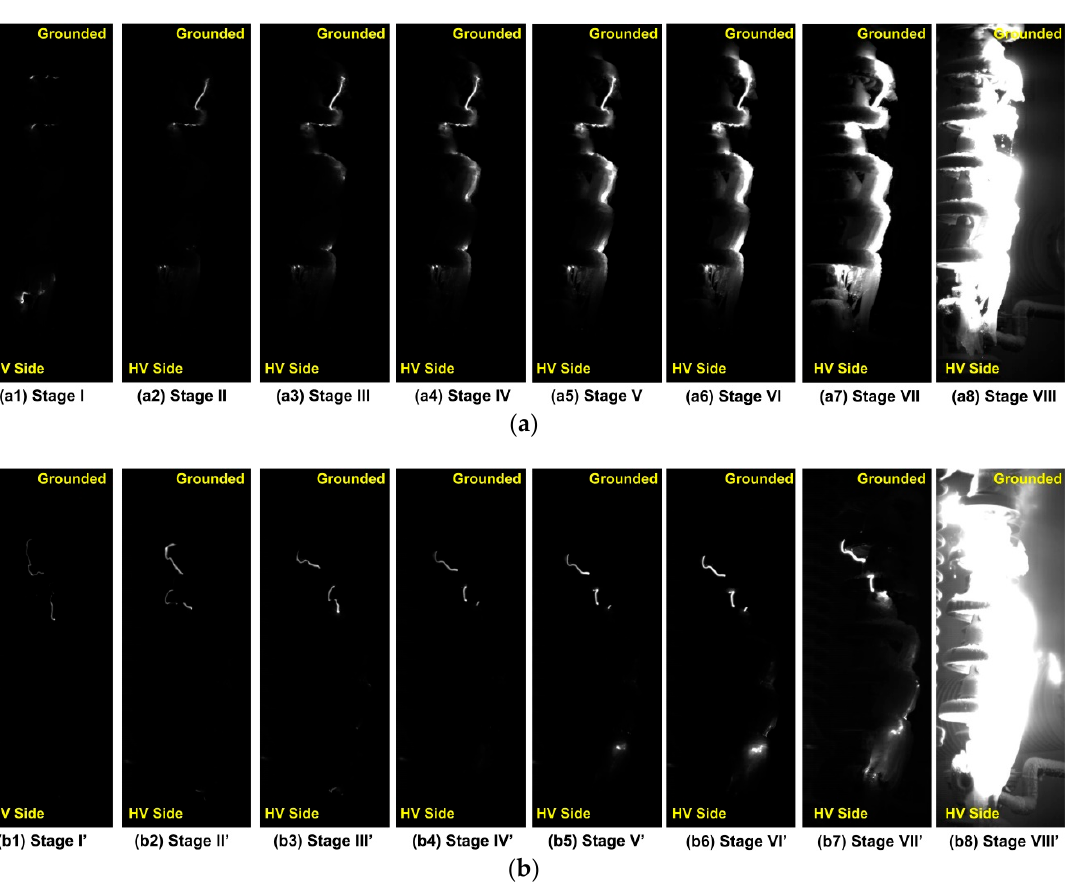
Figure 4. Flashover process of ice-covered insulators with and without ice shedding: ( a ) The discharge phenomena on the insulator without ice shedding; ( b ) the discharge pehnomena on the insulator with the occurrence of ice shedding.